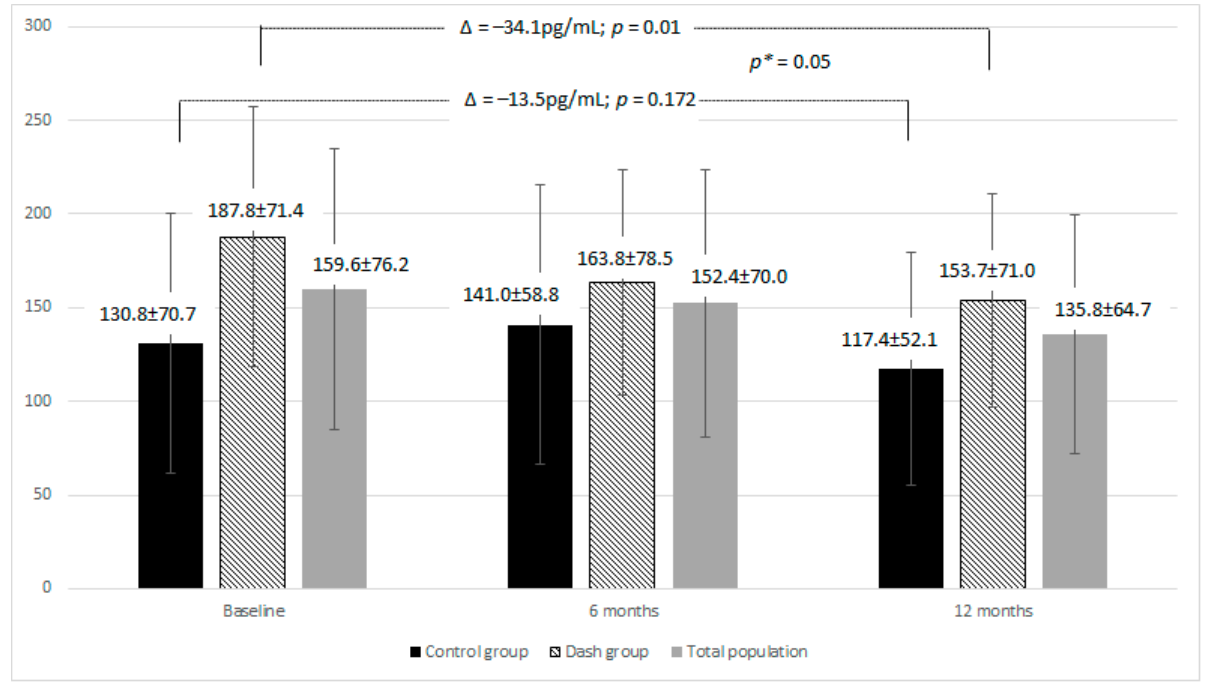
Figure 2. Change in mean plasma MCP-1 concentration (pg/mL) in the whole study group and in subgroups at baseline, and after 6 and 12 months. p indicates differences within the group (paired samples t test). p* indicates the difference between the change in the two groups (independent samples t test).